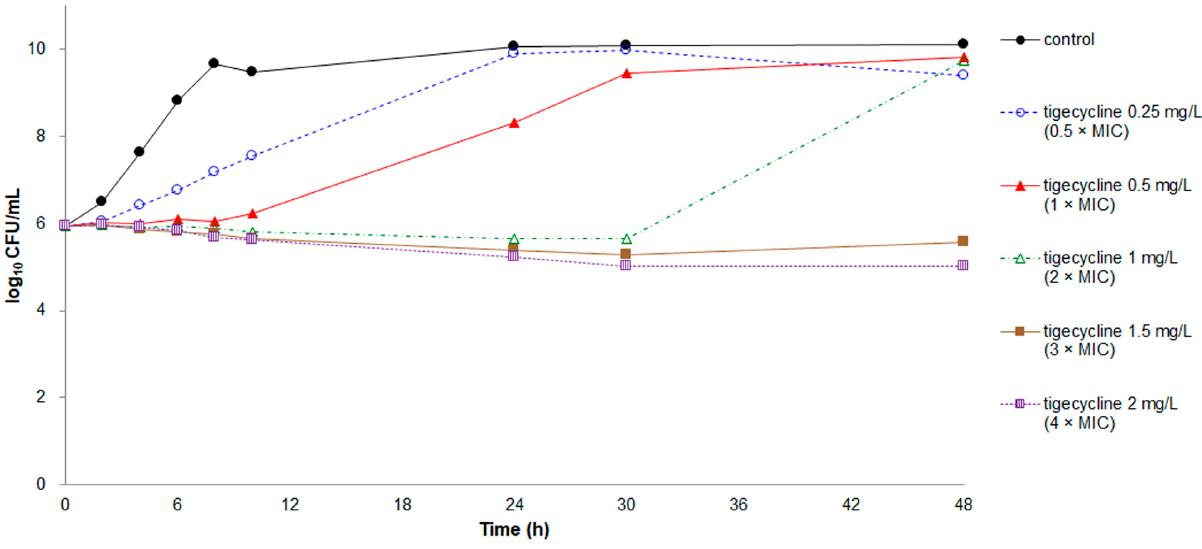
Figure 2. Time-kill assays for tigecycline against E. anophelis strain ED853-49. Data points represent the mean of three experiments. MIC of tigecycline = 0.5 mg/L.